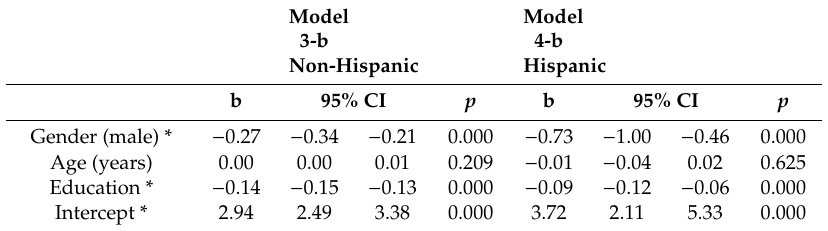
Table 5. Ethnic-specific linear regressions for mean depressive symptoms over 24 years as the